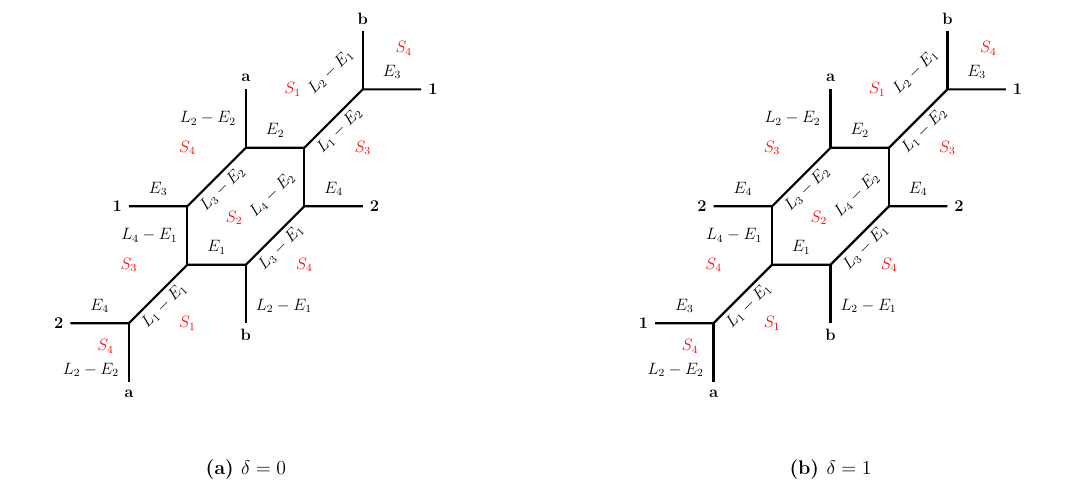
Figure 18 . Alternative presentation of the geometry in (cid:12)gure 17 in the form of a (twisted) (2 ;